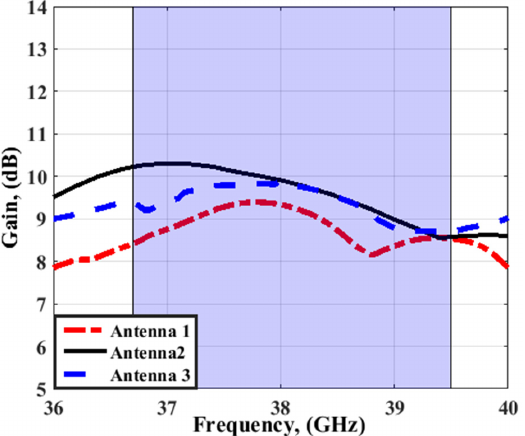
Figure 18. The simulated S 11 outcomes of the MIMO antenna at port 1 at different FSS cell sizes.